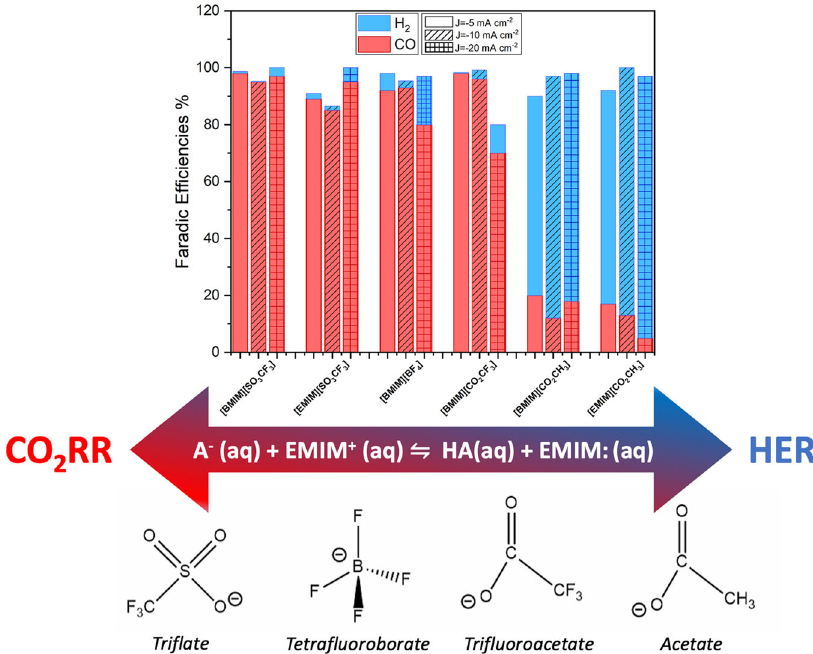
Fig. 3 Faradic ef fi ciency values of the gaseous products generated during the EC CO 2 RR. Chronopotentiometries (CPs) were conducted at constant currents of I = − 20 mA, I = − 10 mA, I = − 5 mA, with the different ILs. Set-up: H-cell; WE: Ag foil; catholyte: 0.3 M IL in ACN; CE: Ni mesh; anolyte: 0.1 M